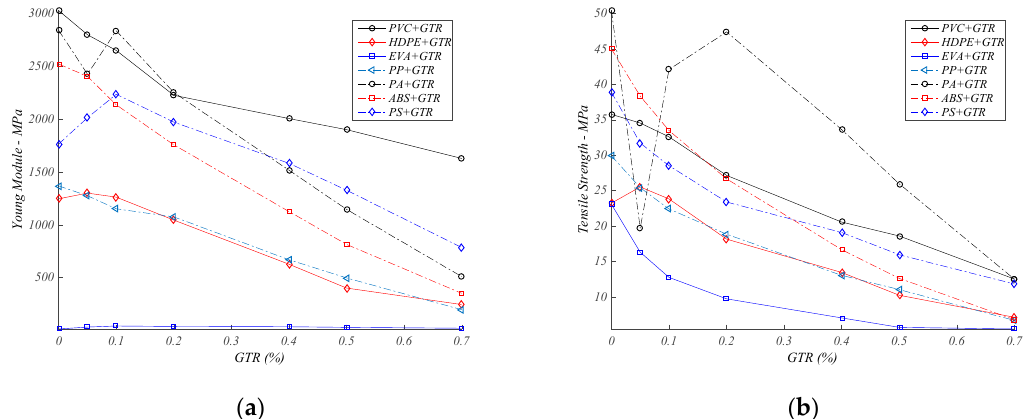
Figure 6. ( a ) Young’s modulus (MPa), ( b ) tensile strength (MPa), for seven polymers / GTR concentrations and particle size <200 μ m.